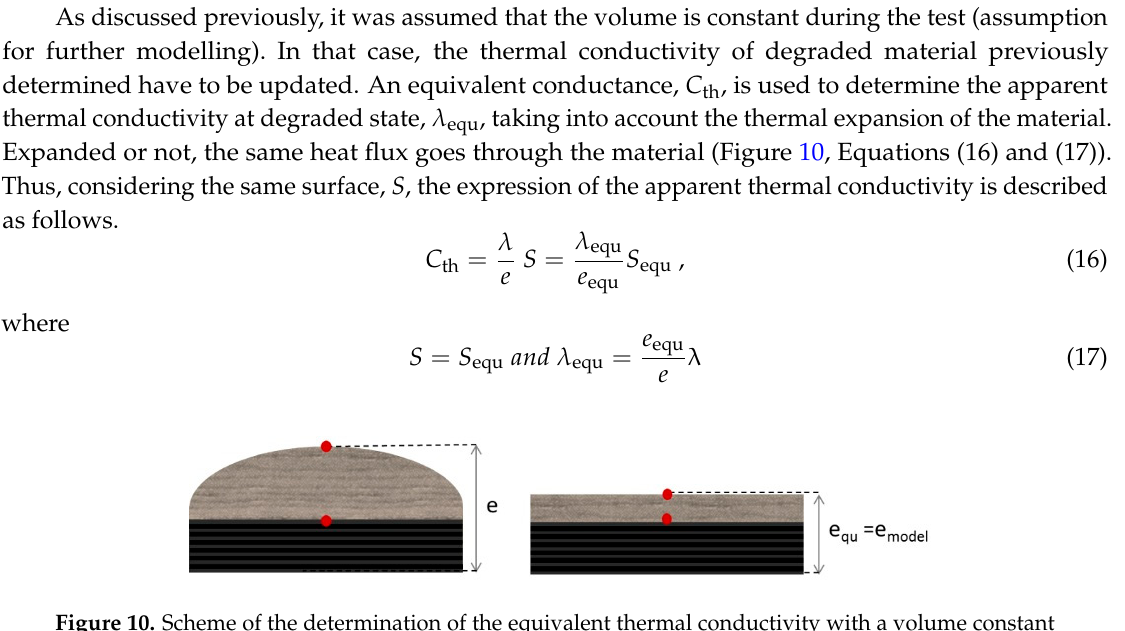
Figure 10. Scheme of the determination of the equivalent thermal conductivity with a volume constant assumption [6].